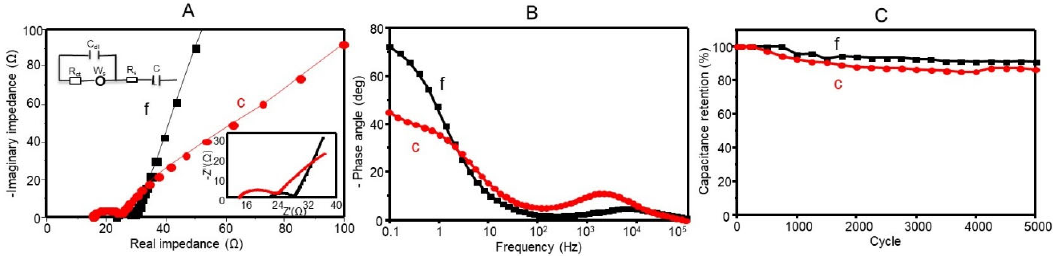
Figure 7. ( A ) Nyquist plots, ( B ) Bode phase plots and ( C ) capacitance retention of (c) symmetric (NG/Cdots/Fe 3 O 4 )//(NG/Cdots/Fe 3 O 4 )) and (f) asymmetric ((NG/Fe 3 O 4 )//(NG/Cdots/Fe 3 O 4 )) devic ‐ es.